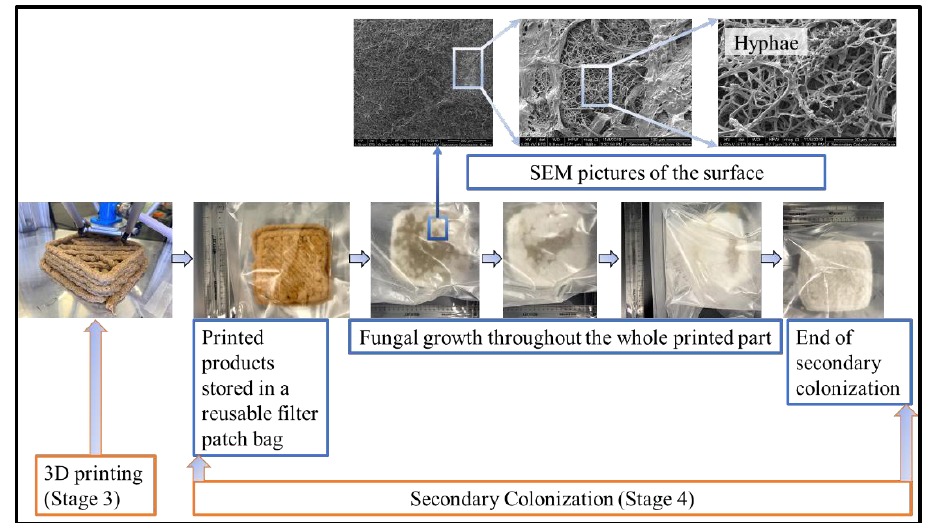
Figure 17. The 3D printing (Stage 3) and secondary colonization (Stage 4) using the prepared mixture from Stage 3.